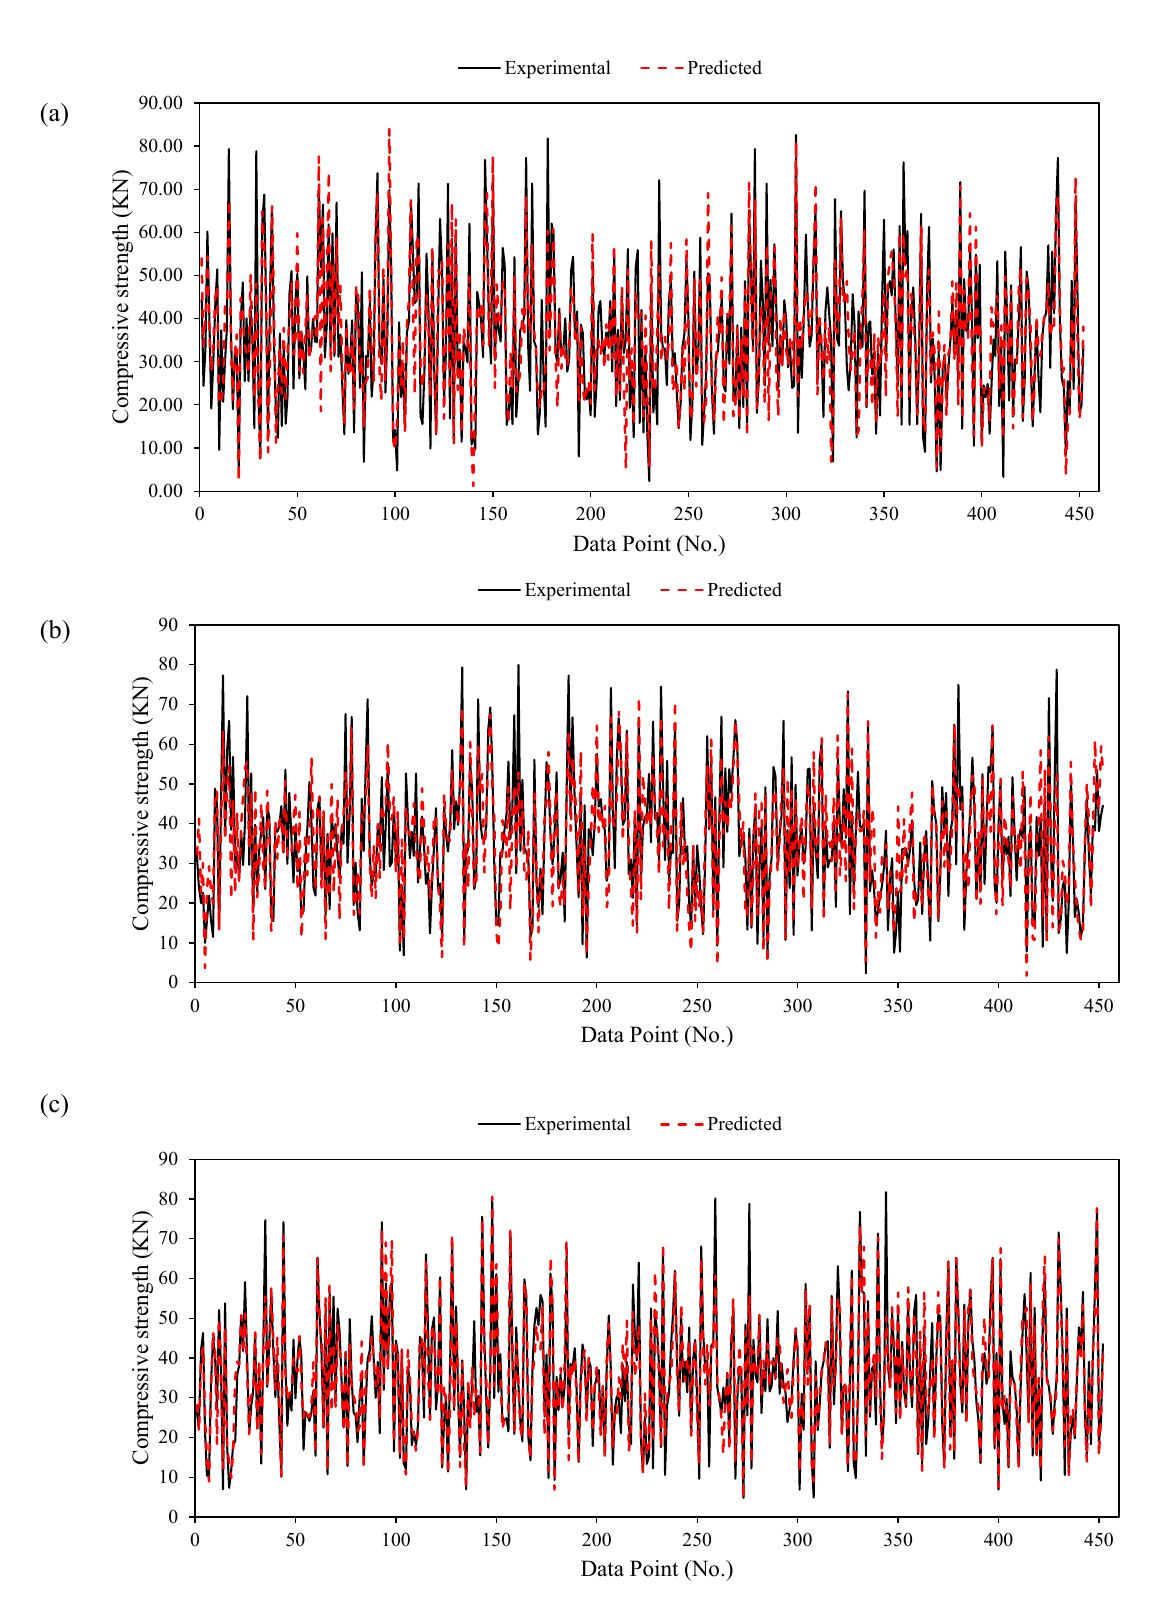
Figure 11. Tracing of experimental results by the predictions: ( a ) ANFIS, ( b ) GEP, and ( c ) GBT.